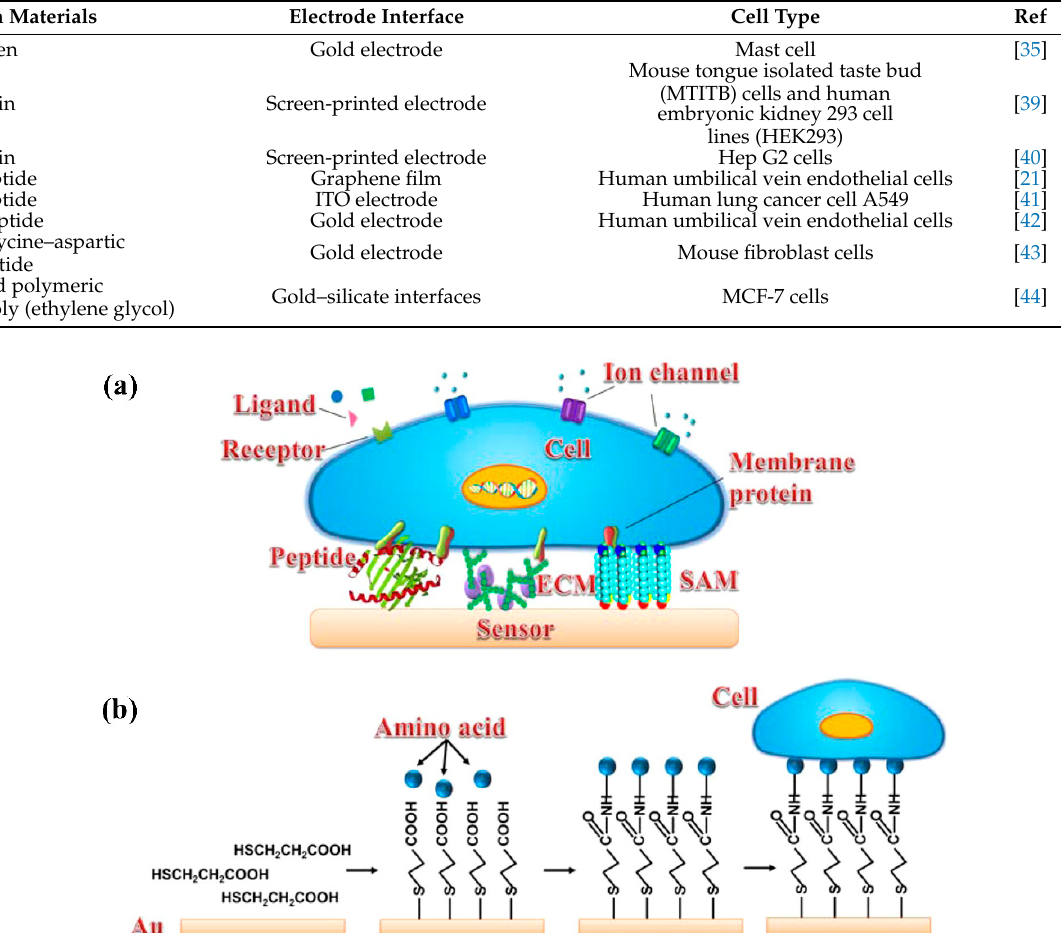
Table 1. Cell immobilization materials in electrochemical cell-based sensors.